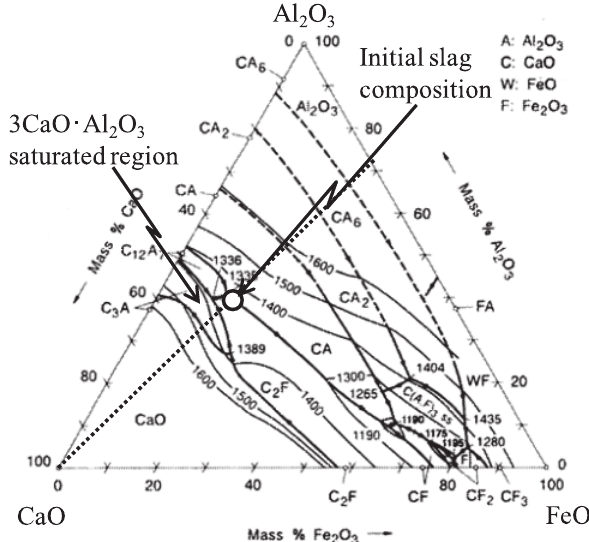
Fig. 2: Phase diagram of Al 2 O 3 -CaO-FeO system 14)